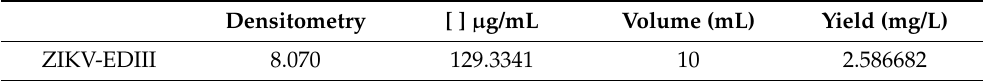
Table 1. Quantification of ZIKV-EDIII by densitometry. Yield per liter of culture. Standard curve